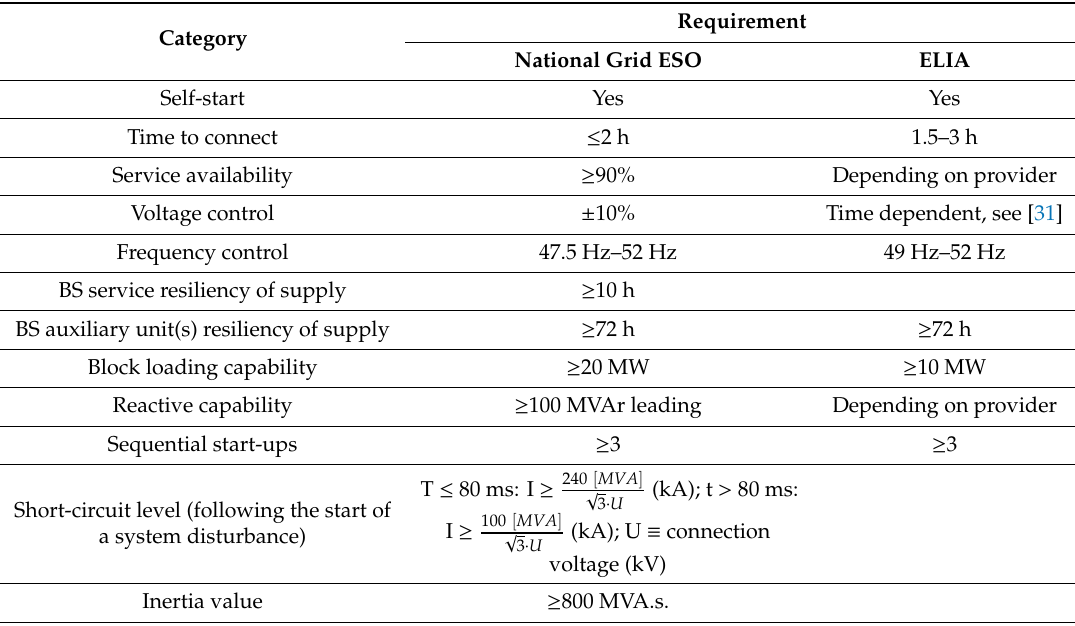
Table 1. List of black-start requirements by ELIA and National Grid Electrical System Operator (ESO)